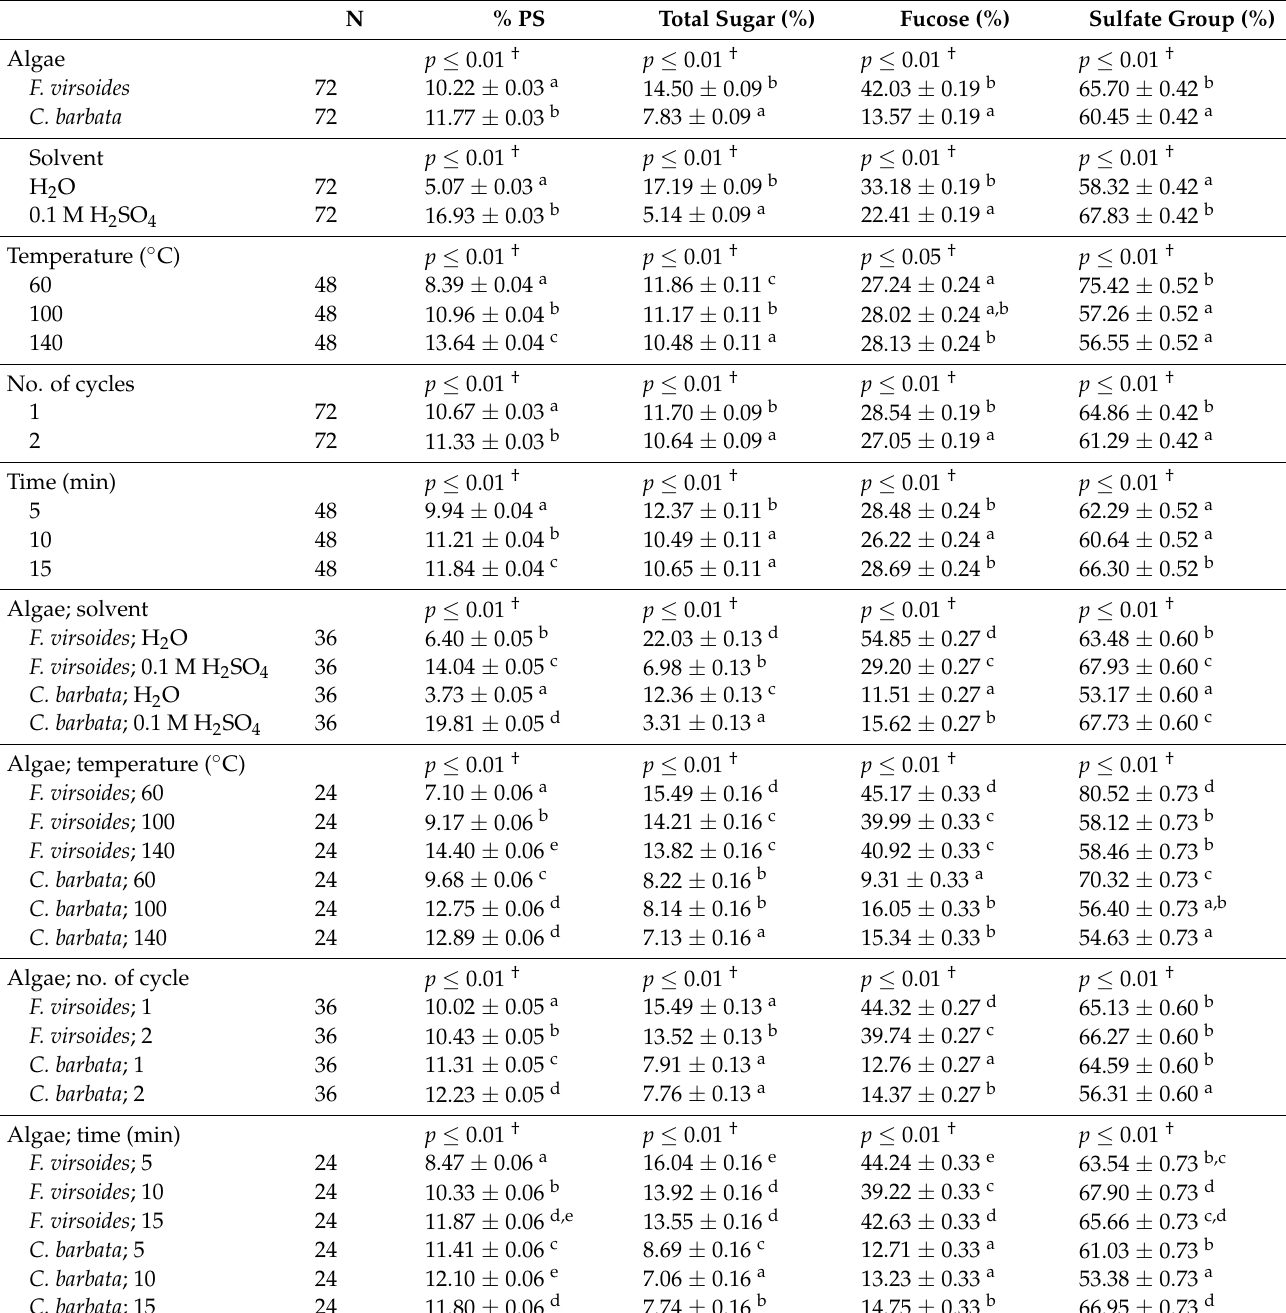
Table 3. Influence of algae species ( F. virsoides and C. barbata ), extraction solvent (water and 0.1 M H 2 SO 4 ), temperature (60, 100, and 140 ◦ C), time (5, 10, and 15 min), and number of cycles (1 and 2) in pressurized liquid extraction on the yield (%PS) and chemical composition of the extracted